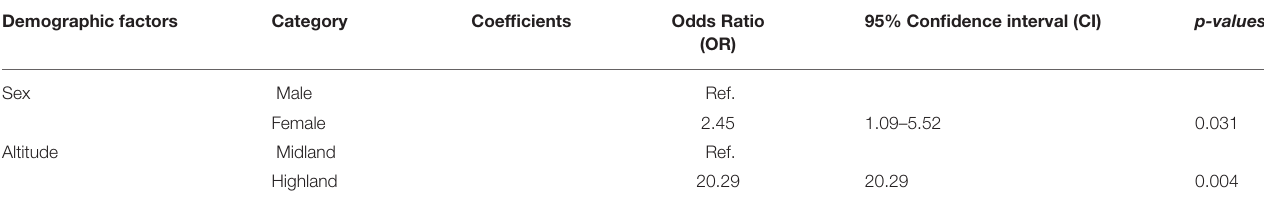
TABLE 5 | The final multivariable mixed-effect logistic regression model. Demographic